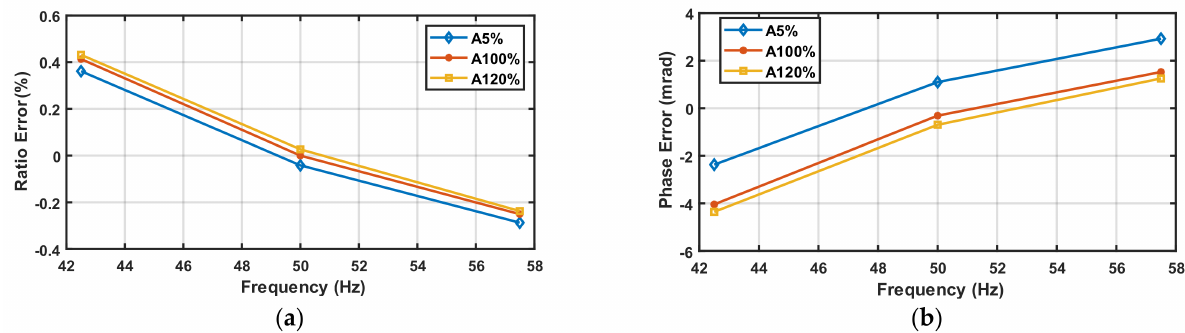
Figure 8. Ratio ( a ) and phase ( b ) errors of LPVT under test at different fundamental amplitudes and frequencies.